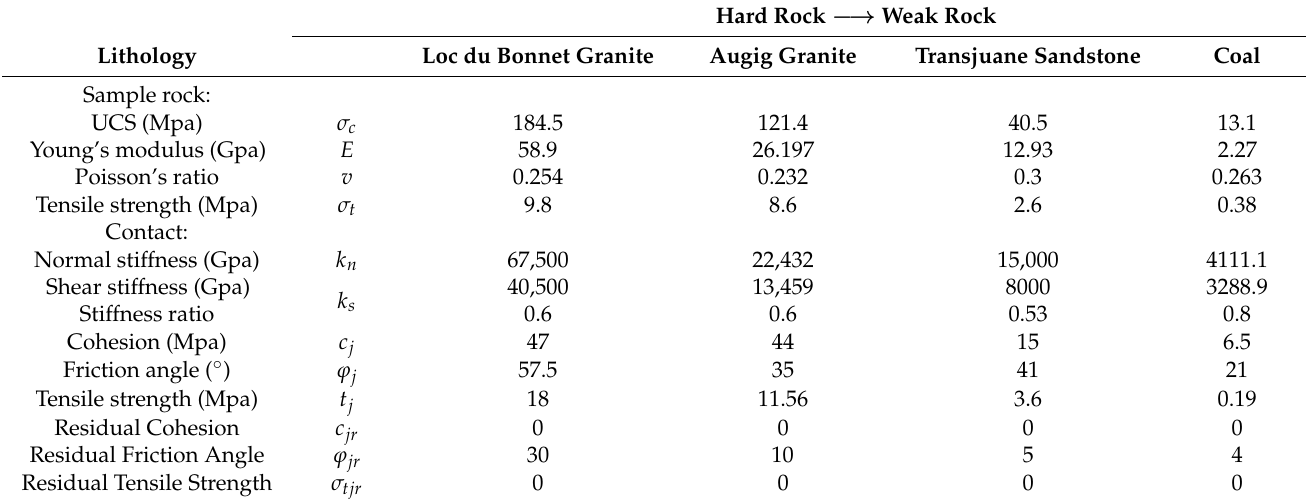
Table 3. Calibrated micro-properties used in the Voronoi model.